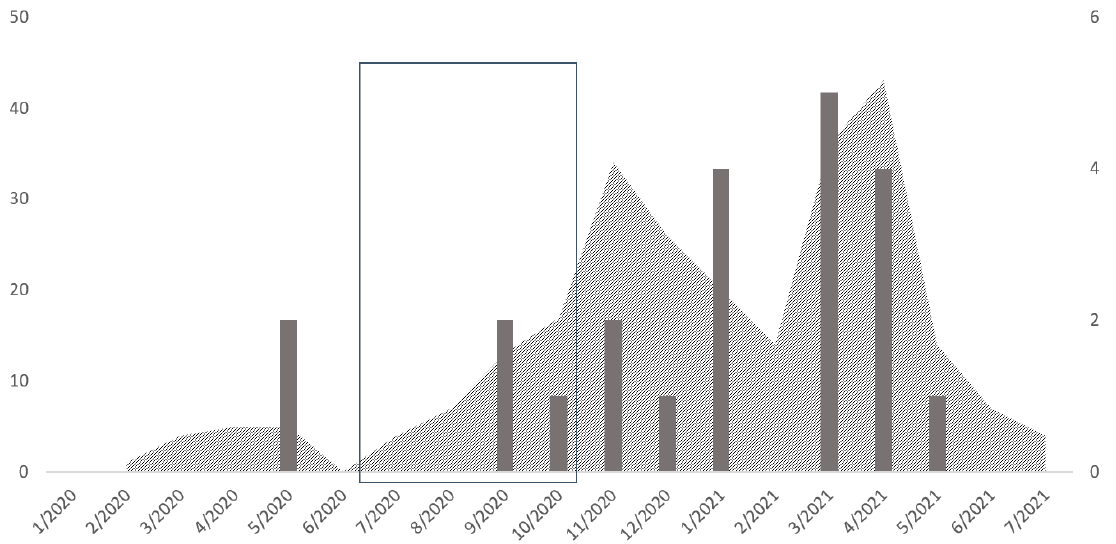
Figure 3. Epidemic curve of COVID-19 cases at ICU (area; y-axis on the left) and COVID-19 plus IA cases at ICU (bars; y-axis on the right); frame gives period of demolition work.